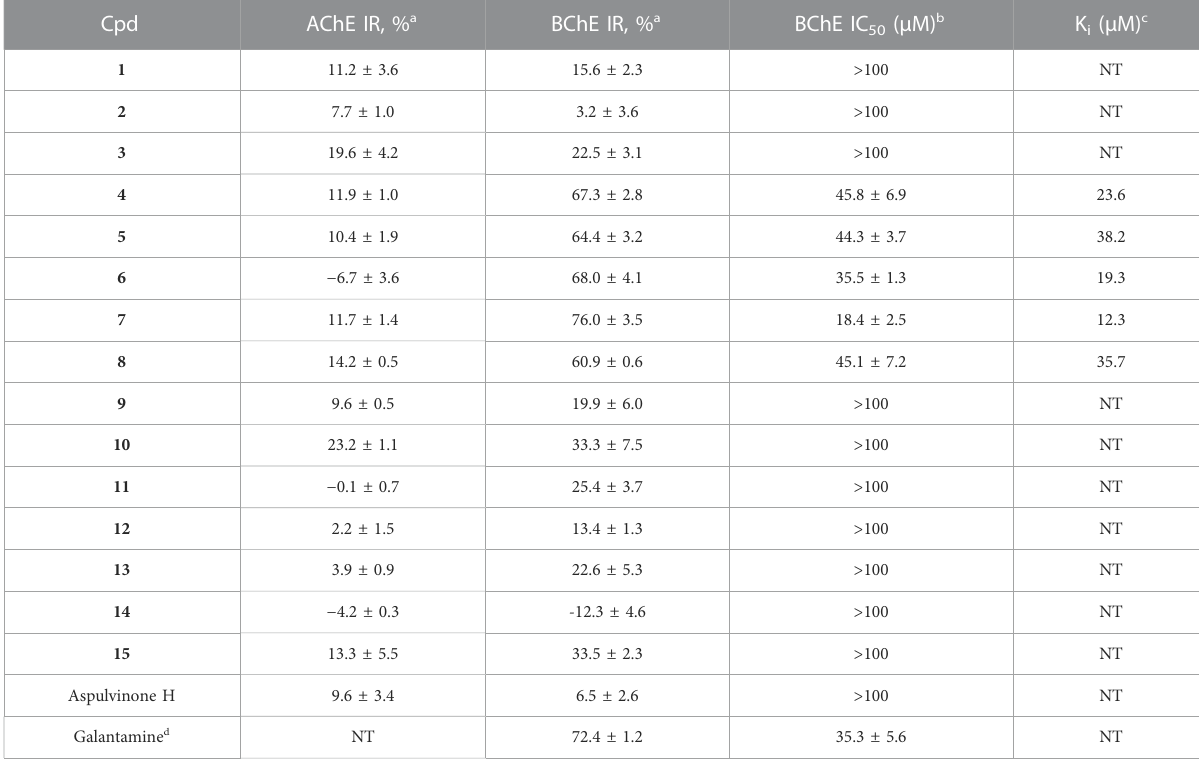
TABLE 2 Inhibitory activities against ChEs of compounds 1 – 15